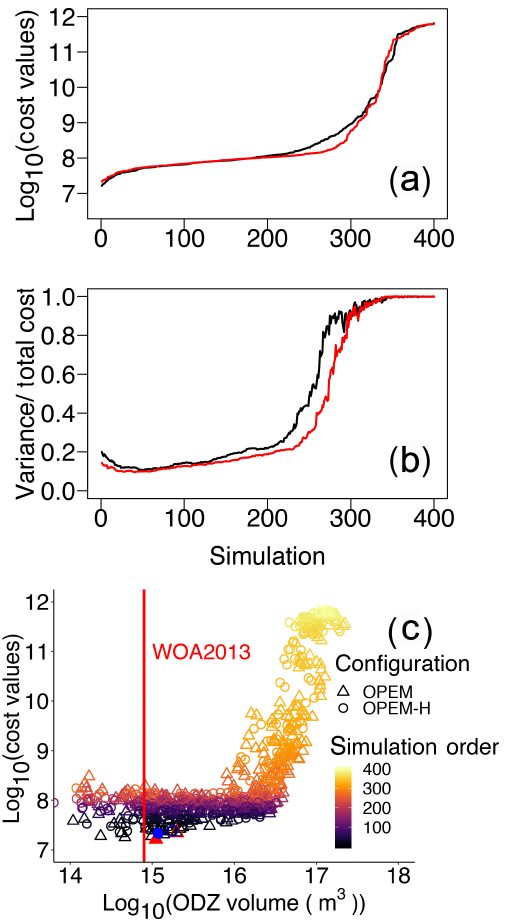
Figure 10. Cost values across all parameter sensitivity simulations ordered from low to high for the two model configurations. Cost values in both misfit and variance (a) and the contributions of vari- ance (b) . Black and red lines are for OPEM and OPEM-H, respec- tively. Total cost versus volume of ODZ (ODZ < 5mmolO 2 m − 3 ) in the simulations with ODZ volume larger than 10 14 m 3 (c) ; colour represents the simulation order as shown in panels (a) and (b) . The red vertical line indicates ODZ volume in WOA 2013 (7 . 945 × 10 14 m 3 ), the solid red triangle and blue circle represent the sim- ulations with minimum cost in OPEM and OPEM-H, respectively, and open red triangle and blue circle are the trade-off